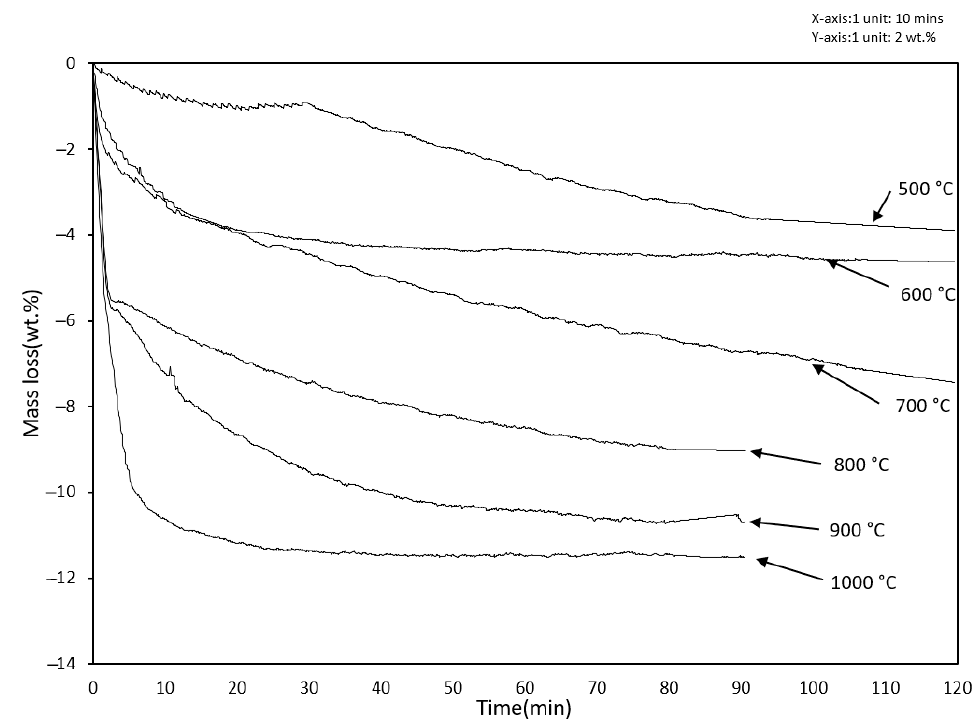
Figure 5. Mass loss changes plotted against time for different temperatures at constant gas flow rate of 4 NL/min.